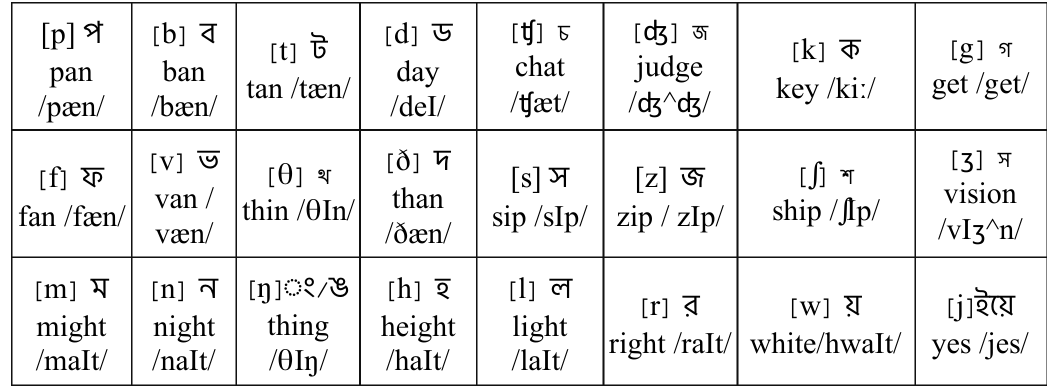
Fig. 8 English-Bengali IPA